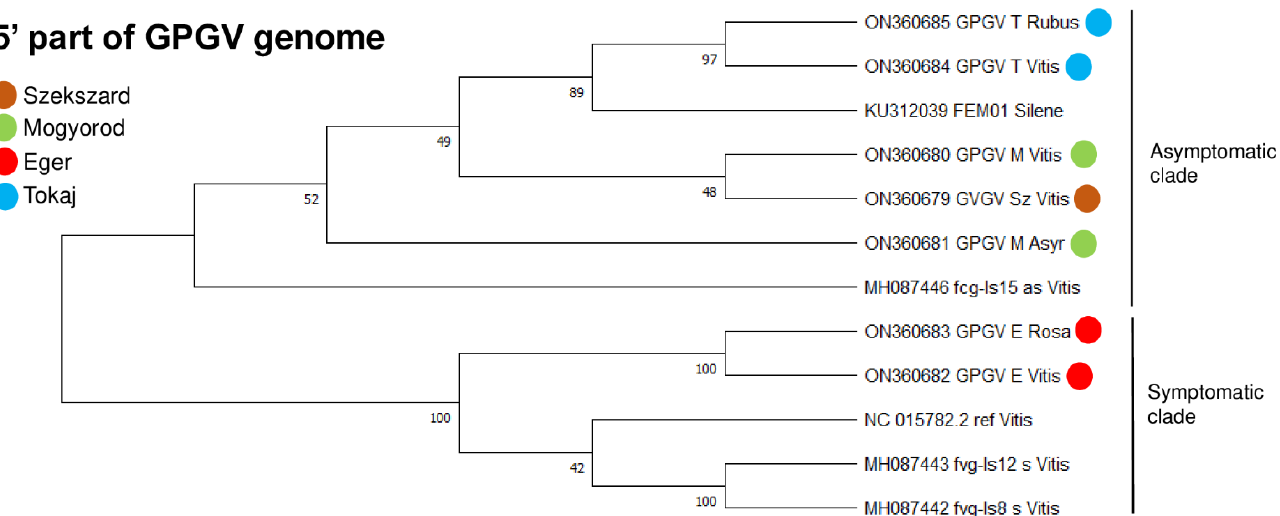
5 of 10 Figure 4 . Evolutionary analysis of MP/CP coding region using the maximum likelihood method.